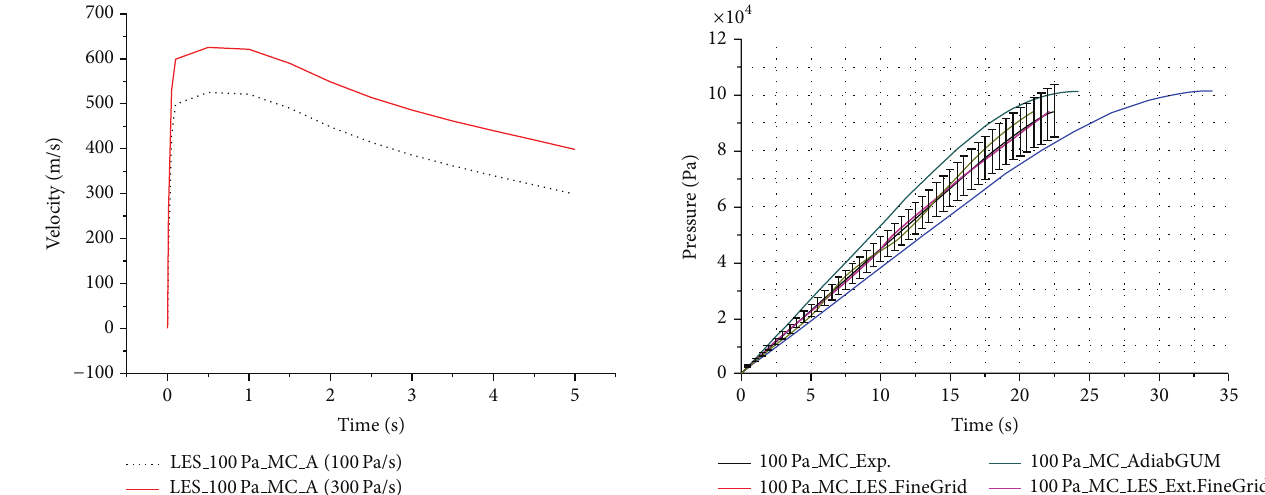
Figure 29: Average pressure time trend for different grids (100 Pa,